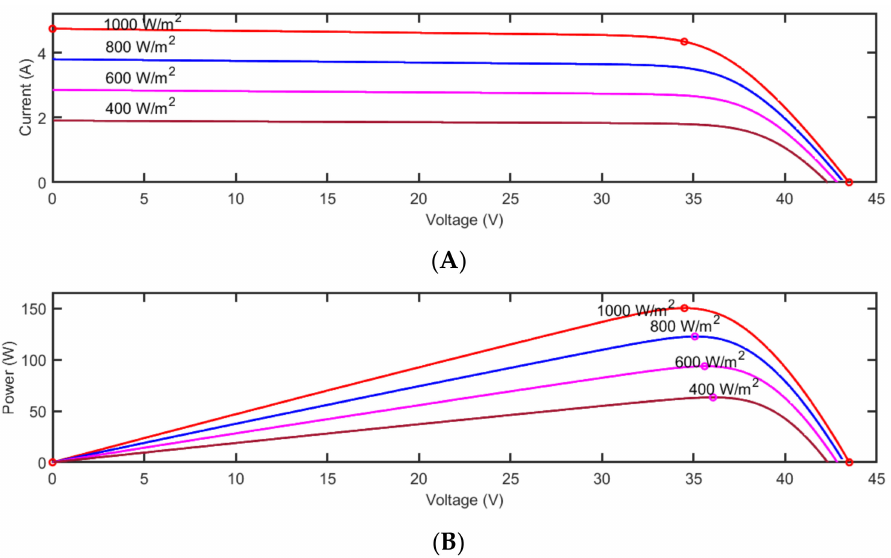
Figure 3. ( A ) Current–Voltage characteristics at T = 25 ◦ C and varying irradiance levels. ( B ) The Power–Voltage characteristics at T = 25 ◦ C and varying irradiance levels.